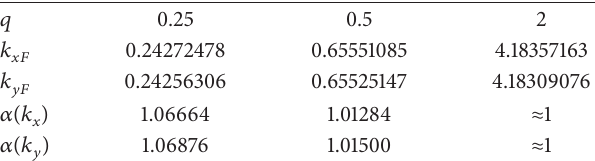
Table 3: Fermi momentums and dispersion relation exponents with different charges for 𝑚 = 0 and 𝑎 2 = 0.01